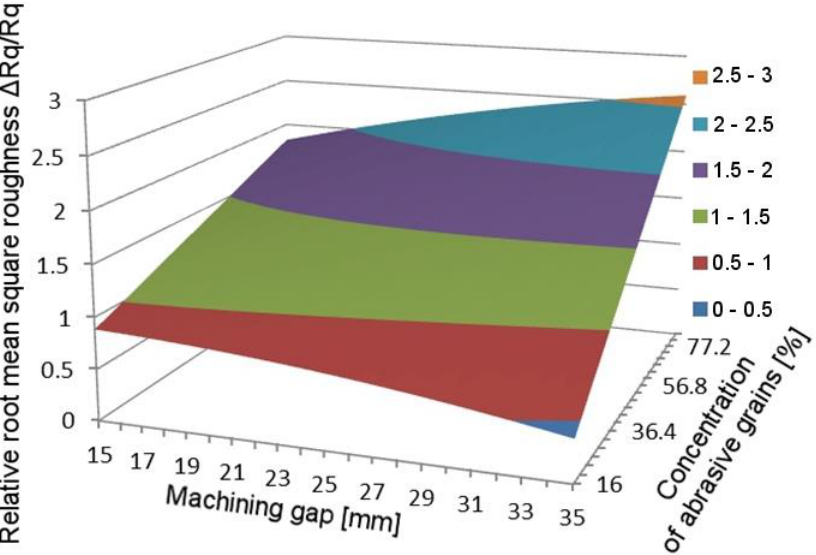
Figure 26. The impact of machining gap width and concentration of abrasive grains, at constant processing time ( T = 15 min), on relative change in roughness Δ Rq / Rq (correlation coefficient R = 0.57).